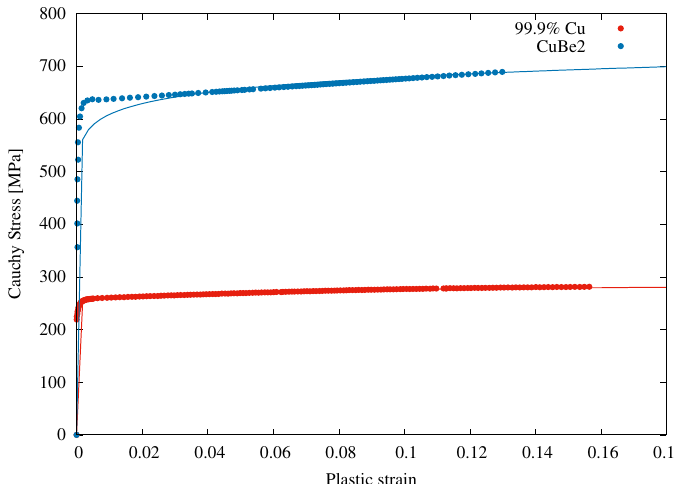
Figure 3. Hardening curves in a tensile test in the rolling direction and the identified Hollomon’s model for pure Cu and CuBe2